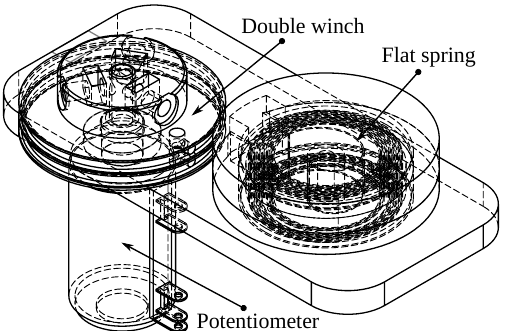
Figure 16. Draw-wire sensor